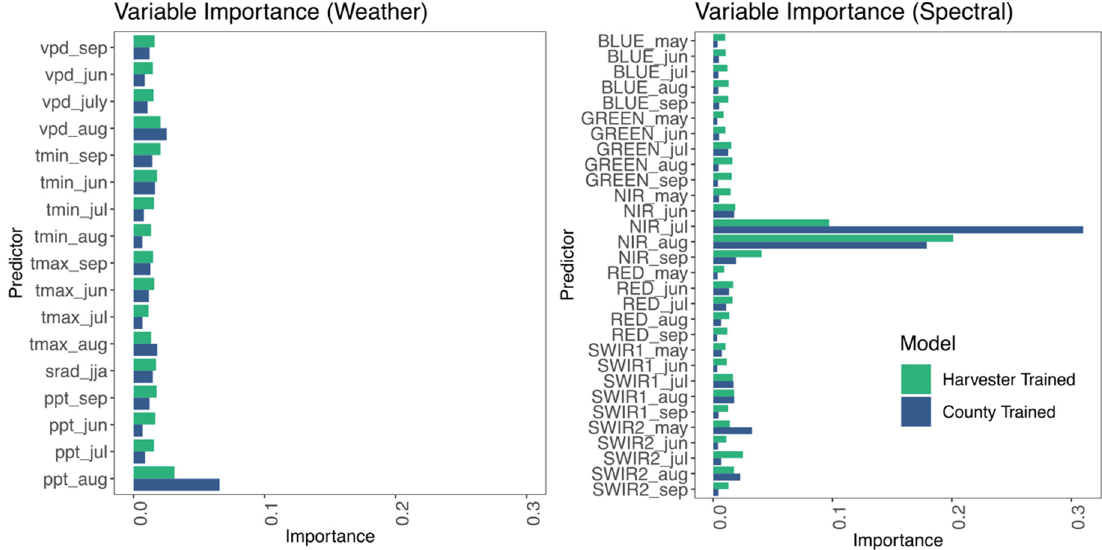
Figure 4. Variable Importance from County- and Harvester-Trained random forest (RF). The figure displays variable importance, measured by increase in node purity (decrease in variance), from random forest models trained at the pixel-scale using harvester yield data and the county-scale using NASS data. Both models were trained on data from 2008 to 2018 using monthly Landsat and weather data. Table 5. Sentinel-2 Vegetation Index Performance. Validation statistics reported from performance on held-out validation set for a suite of vegetation